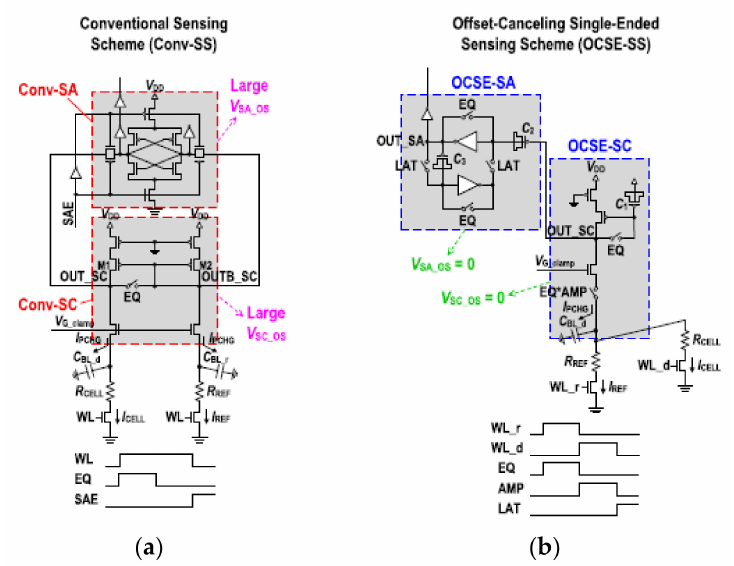
Figure 15. ( a ) Two-BL precharge architecture (2 BLPA) differential-sensing structure with no offset voltage cancellation; ( b ) one-BL precharge architecture (1 BLPA) single-ended sensing structure offset voltage cancellation [86].